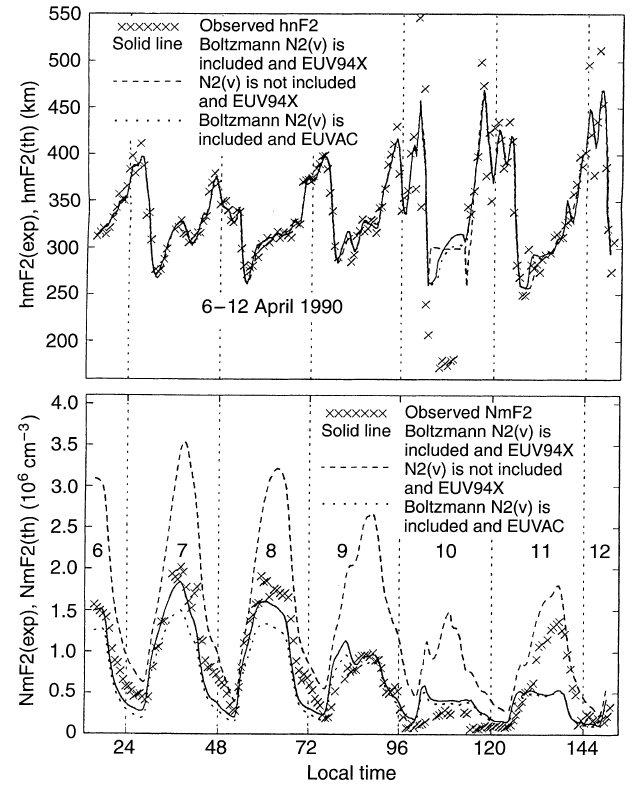
Fig. 7. Observed ( crosses ) and calculated F2 peak parameters above Millstone Hill for the magnetically quiet and disturbed period 6–12 April 1990 for the EUV94X solar flux model ( solid and dashed lines ) and the EUVAC solar flux model ( dotted lines ). The solid and dotted lines are hmF2 and NmF2 from the IZMIRAN model when the Boltzmann populations of the first five vibrational levels of N 2 ( v ) are included in the calculated O (cid:135) (cid:133) 4 S (cid:134) recombination rate, and dashed are hmF2 and NmF2 when N 2 ( v ) is not included in